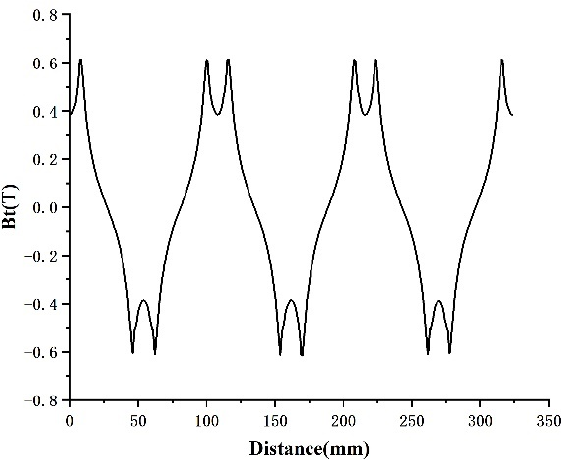
Figure 6. Circumferential air gap density component.